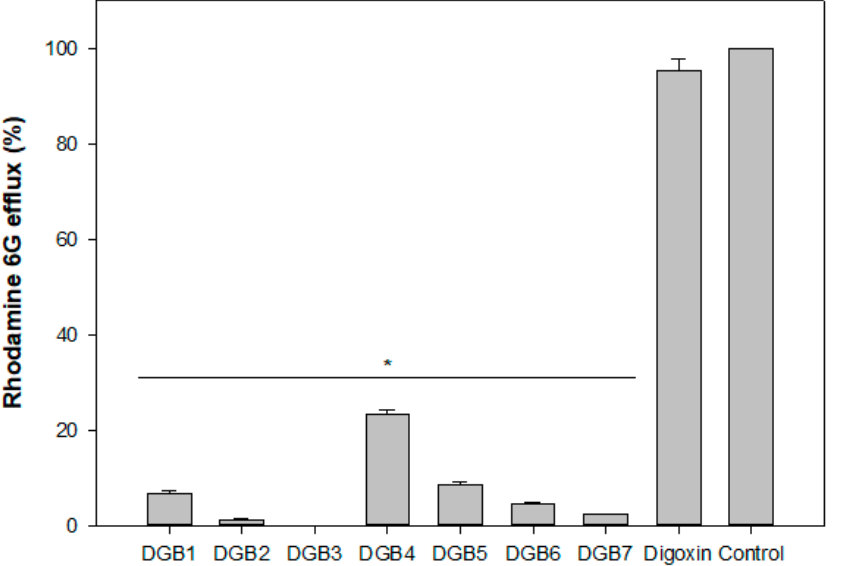
Figure 4. Determination of Rhodamine 6G efflux: Cells (strain AD/124567) were incubated in the presence or absence of digoxin and its derivatives, loaded with rhodamine 6G, and incubated with 0.2% glucose. The cells were then centrifuged, and the fluorescence of rhodamine 6G in the supernatant was measured. Data refer to three independent experiments. Results are expressed as % of efflux in comparison to controls (untreated cells); (*) p < 0.05 in comparison to controls. DGB 1–7: digoxin derivatives.